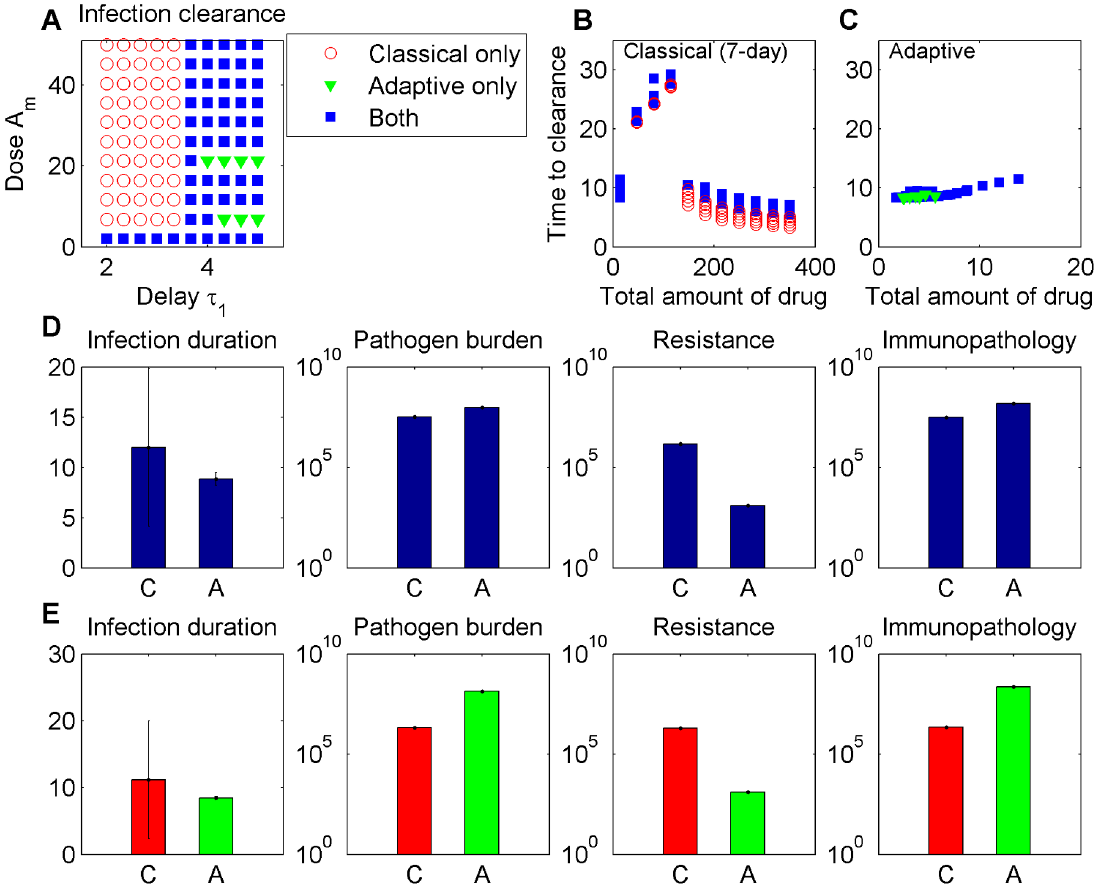
Fig 9. Comparison of classical and adaptive regimes, for variable dose and treatment delay. Different treatment scenarios are simulated up to T = 30 days post-infection. Classical treatment assumes a fixed duration of 7 days, while in the adaptive regime, drug uptake is related to bacterial density above the threshold Ω = B ( τ 1 ). Parameters as in Table 1. A) Clearance of infection by 30 days can be obtained: via classical treatment only (red), via adaptive treatment only (green) or using either regime (blue). B)-C) The amount of drug deployed in each treatment and the associated time to clearance. Longer time to clearance in the classical regime at low doses corresponds to relapsing infection after treatment cessation, and delayed clearance by host immunity. D) ¼ 3 : 2 (cid:10) 10 7 , Treatment outcomes in those cases where both regimes, classical/C, and adaptive/A, can yield infection clearance (mean ± sd), with: (cid:2) B C tot (cid:2) B A ¼ 9 : 6 (cid:10) 10 7 ; (cid:2) R C ¼ 1 : 4 (cid:10) 10 6 , (cid:2) R A ¼ 1 : 3 (cid:10) 10 3 ; (cid:2) H C ¼ 3 (cid:10) 10 7 , (cid:2) H A ¼ 1 : 5 (cid:10) 10 8 . E) Treatment outcomes in those cases where clearance can be achieved tot tot tot tot tot ¼ 2 : 1 (cid:10) 10 6 , (cid:2) B A ¼ 1 : 4 (cid:10) 10 8 ; (cid:2) R C ¼ 2 : 0 (cid:10) 10 6 , (cid:2) R A ¼ 1 : 3 (cid:10) 10 3 ; (cid:2) H C ¼ 2 : 2 (cid:10) 10 6 , (cid:2) H A ¼ 2 : 3 (cid:10) 10 8 exclusively via one or the other regime (mean ± sd), with: (cid:2) B C tot tot tot tot tot tot